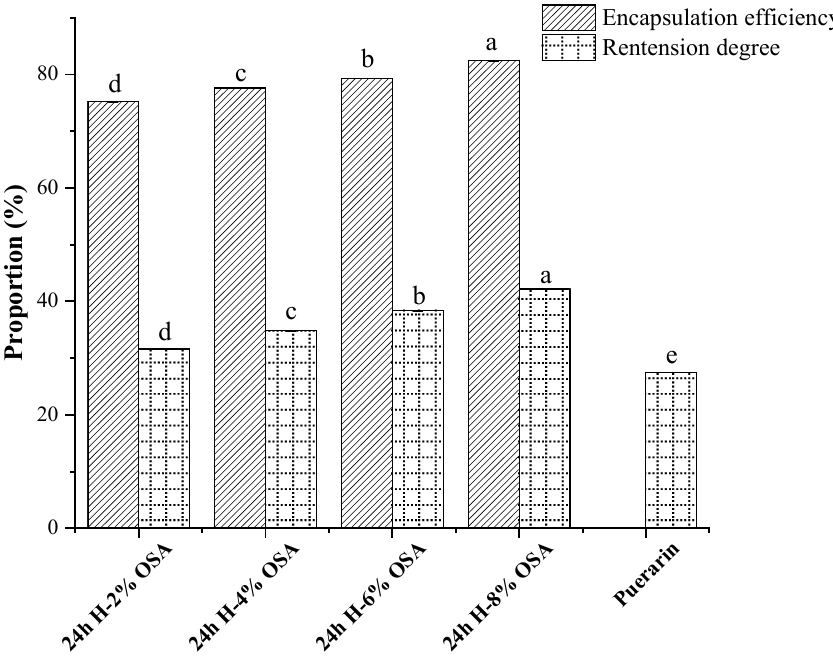
Figure 9. Retention degree and microencapsulation efficiency (MEE) of puerarin in samples before and after storage. A significant difference for the same indicator in different samples is indicated with different letters ( p < 0.05).